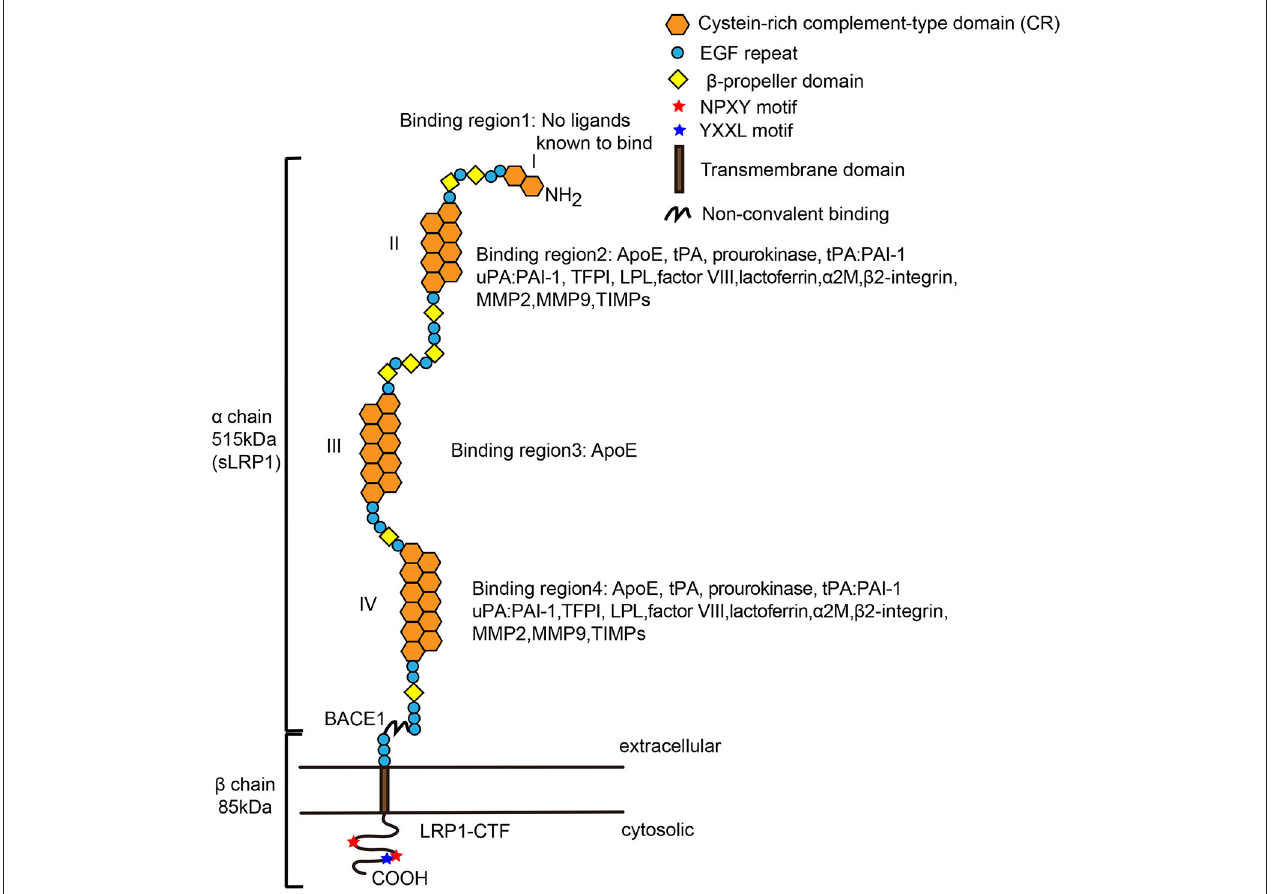
FIGURE 1 | Structure of mature low-density lipoprotein receptor-related protein-1 (LRP-1). LRP1 is a multifunctional receptor that binds a large spectrum of extracellular and intracellular ligands. The α chain contains long modular arrays of acidic cysteine-rich complement-type repeats (CRs), along with epidermal growth factor (EGF)-like domains and β -propeller modules. Also, it consists of four ligand-binding regions (I, II, III, and VI), which are composed of 2, 8, 10, and 11 CRs, respectively. The cytoplasmic tail contains two NPxY motifs that are required for endocytosis and multiple signaling pathways. LRP1 has an YXXL motif adjacent to the second NPxY motif, enabling rapid endocytosis. The β chain also interacts with scaffolding proteins such as PSD-95, Dab-1, and FE-65. Regions II and IV bind most of the currently mapped known ligands of LRP1. β -Secretase (BACE1) cleaves the extracellular domain of LRP1 to form sLRP1 and LRP1-CTF (LRP1-C-terminal fragment). Both extra- and intracellular chains can act independently of each other when the α chain is shed as a soluble LRP1 and the β chain translocates to the nucleus and activates gene transcription and signaling cascades. LPL, lipoprotein lipase; ApoE, apolipoprotein E; COOH, carboxy terminal; EGF, epidermal growth factor; NH2, amino terminal. The image of Figure 1 was modified from the reference ( 75), adding details to the pictures of the ligands of